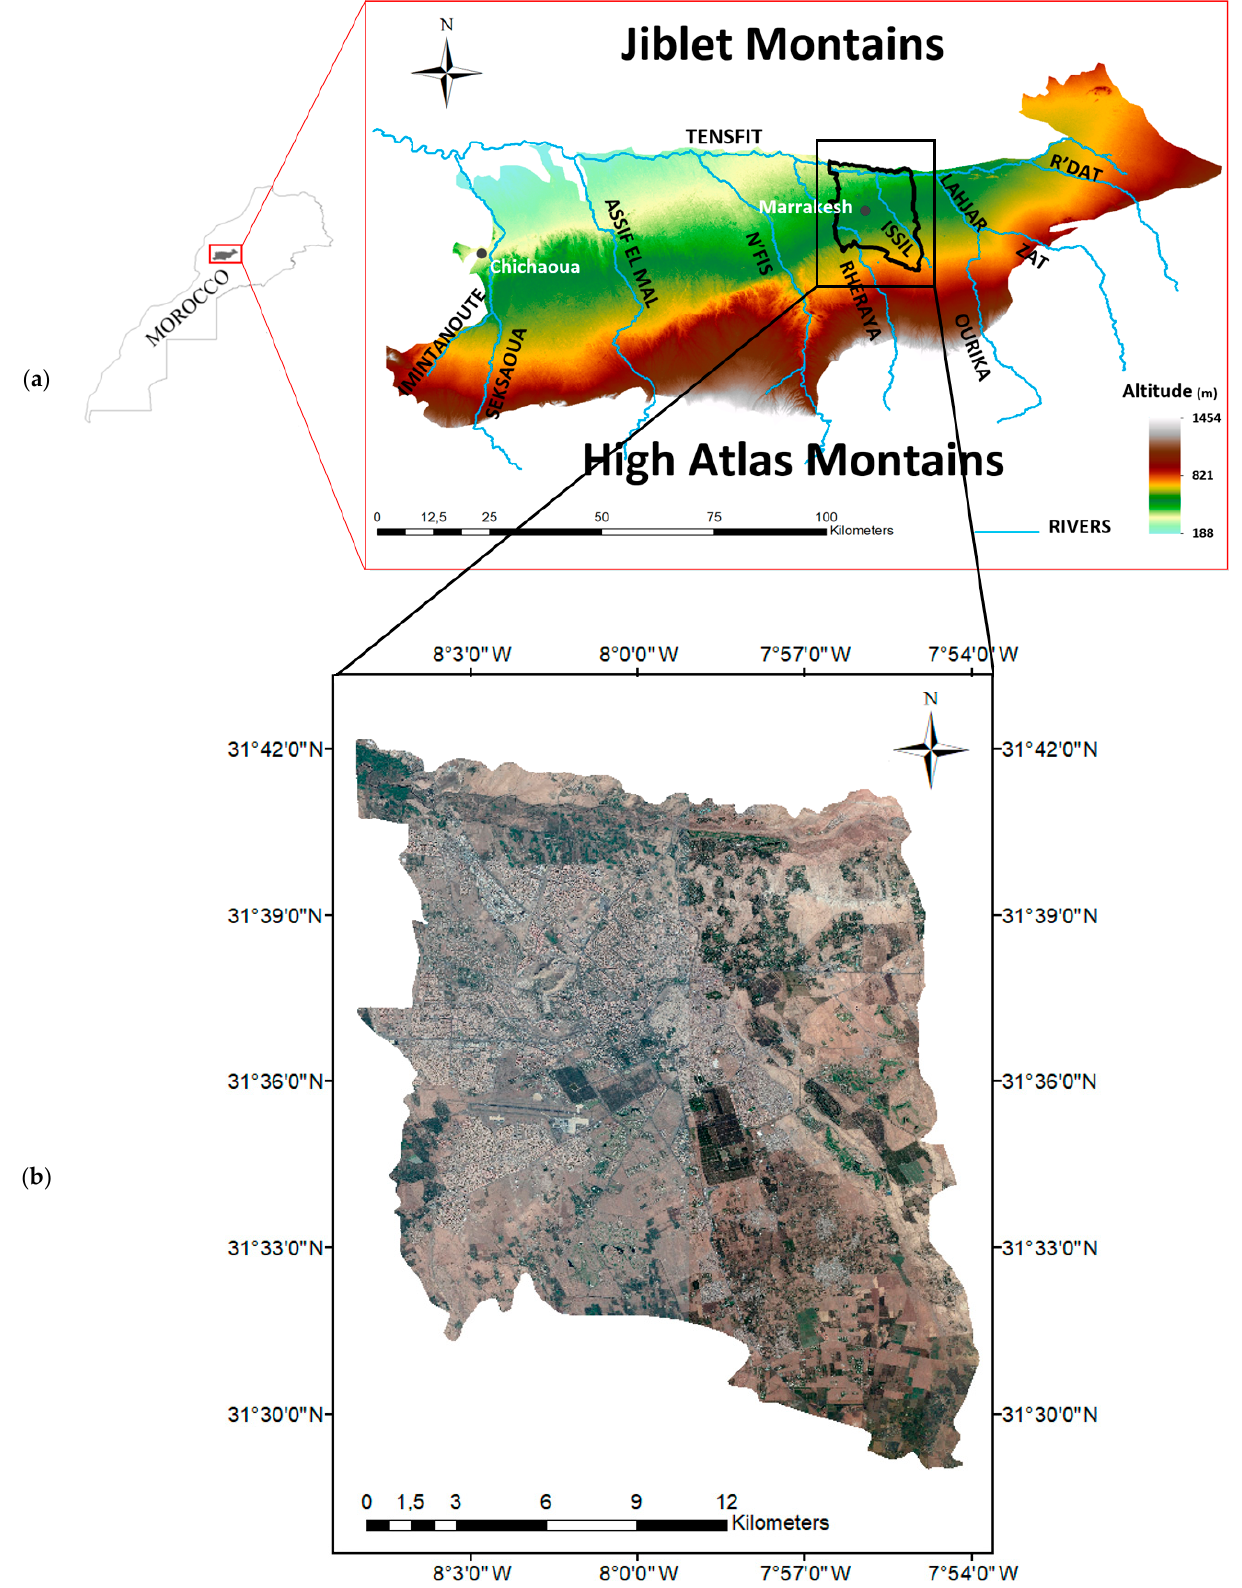
Figure 1. ( a ) Topography of the Haouz Plain and location of the study area. ( b ) Satellite image of the study area .